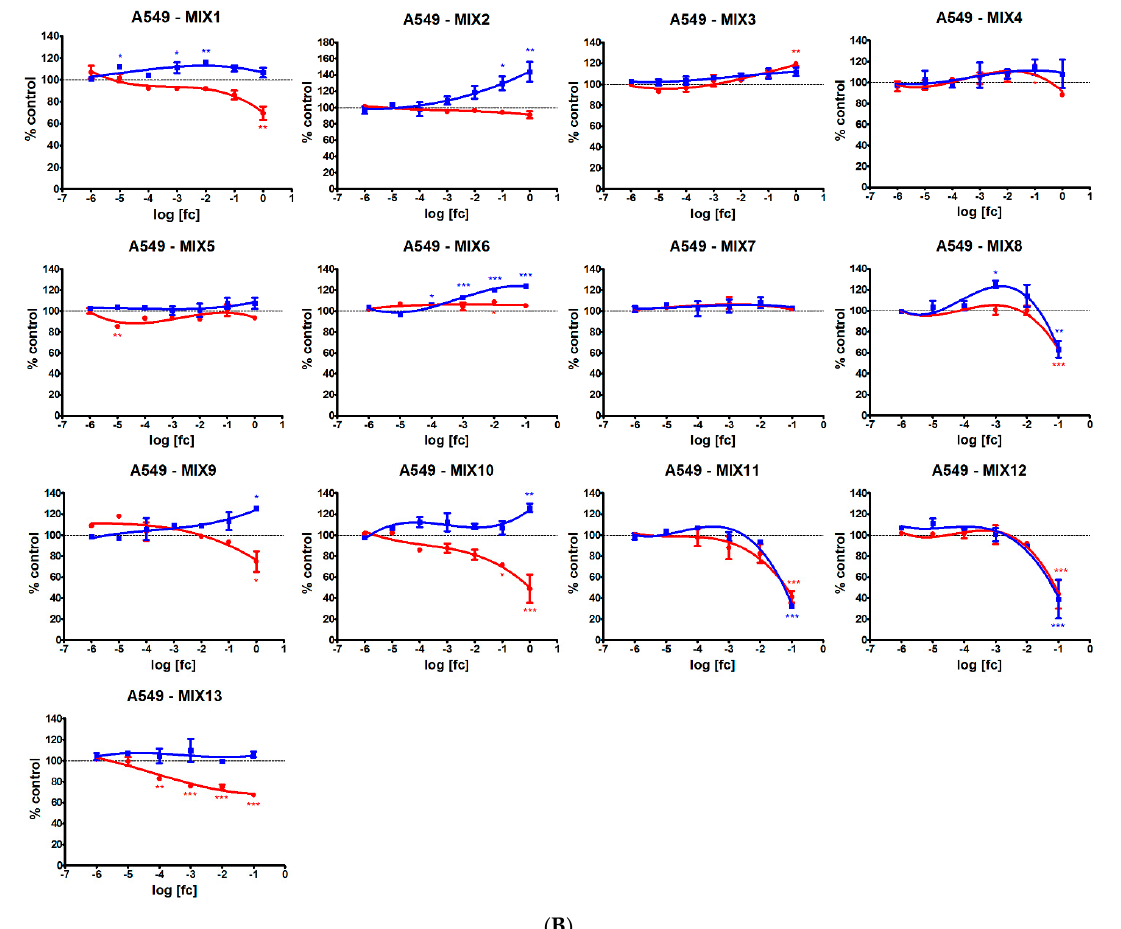
Figure 1. Dose-response curves related to MTS (blue lines) and CyQuant (red lines) assays in ( A ) HepG2 and ( B ) A549 cell lines treated with the 13 pesticide mixtures for 24 h. Data represent mean absorbance (MTS) and fluorescence (CyQuant) signals of three independent experiments normalized to control cells set as 100%. Concentrations are expressed as log of the field concentration [fc] dilution applied. Asterisks indicate the level of significance: * p < 0.05; ** p < 0.01; *** p < 0.001. Two of the mixtures featuring QUI (MIX6 and MIX7) induced metabolic activity in HepG2 but did not affect cell proliferation; in A549, only MIX6 determined the same pat- tern, whereas MIX7 had no effect. MIX13, containing QUI and DIM, dose-dependently decreased cell proliferation but did not affect metabolic activity in both cell lines. Mixtures containing FOL (MIX9 and MIX10) were cytotoxic at field concentrations, reducing cell proliferation by about 70 and 77% in HepG2 and by about 25 and 51% in A549, respec- tively, for MIX9 and MIX10. At the same field concentrations, MIX10 decreased metabolic activity by about 40% in HepG2 but both MIX9 and MIX10 increased it in A549 by about 25%. The most cytotoxic mixtures were those featuring MAN which, at 1:10 field concen- trations, severely reduced metabolic activity and cell proliferation in both cell lines. In HepG2, effects were even evident from 1:100 dilution in cells treated with MIX8 and MIX12 and from 1:10,000 dilution in cells treated with MIX11.